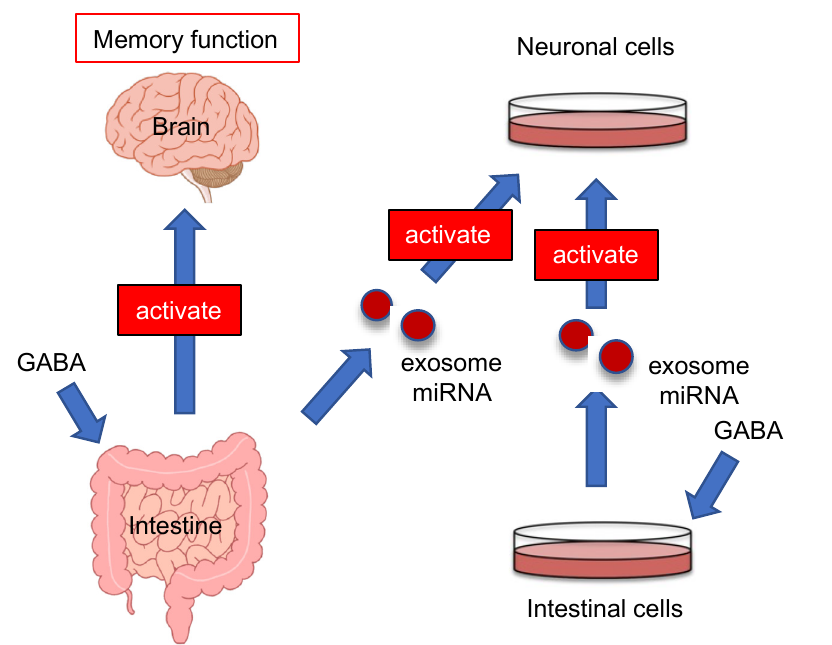
Figure 7. Schematic diagram of GABA function. 360